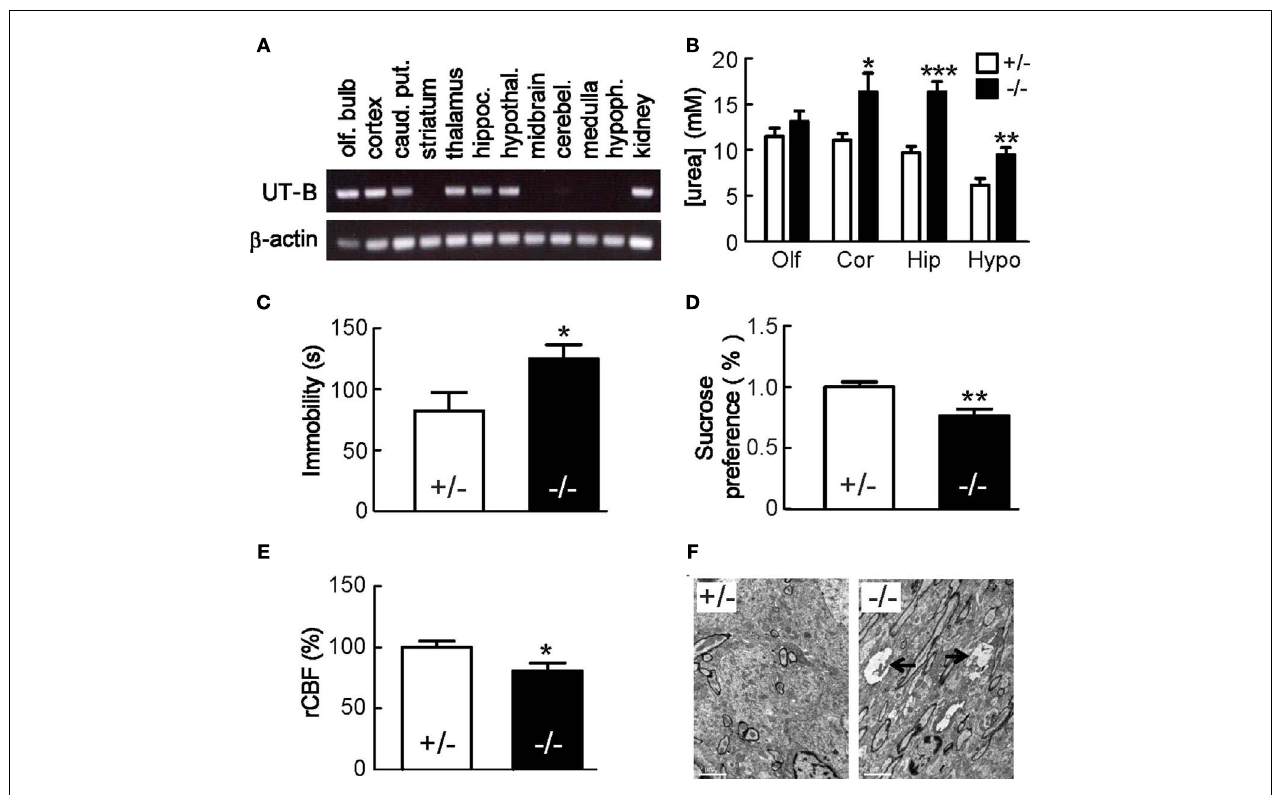
Immobility time was recorded for 5min. (D) Sucrose preference test. Mean ± SE, n = 15. (E) rCBF was assessed by laser Doppler flowmetry. Mean ± SE, n = 10. (F) Representative transmission electron microscopic images of the hippocampus, which show swelling of unmyelinated fibers with myelin figure in UT-B null mice. Reproduced from Li et al.